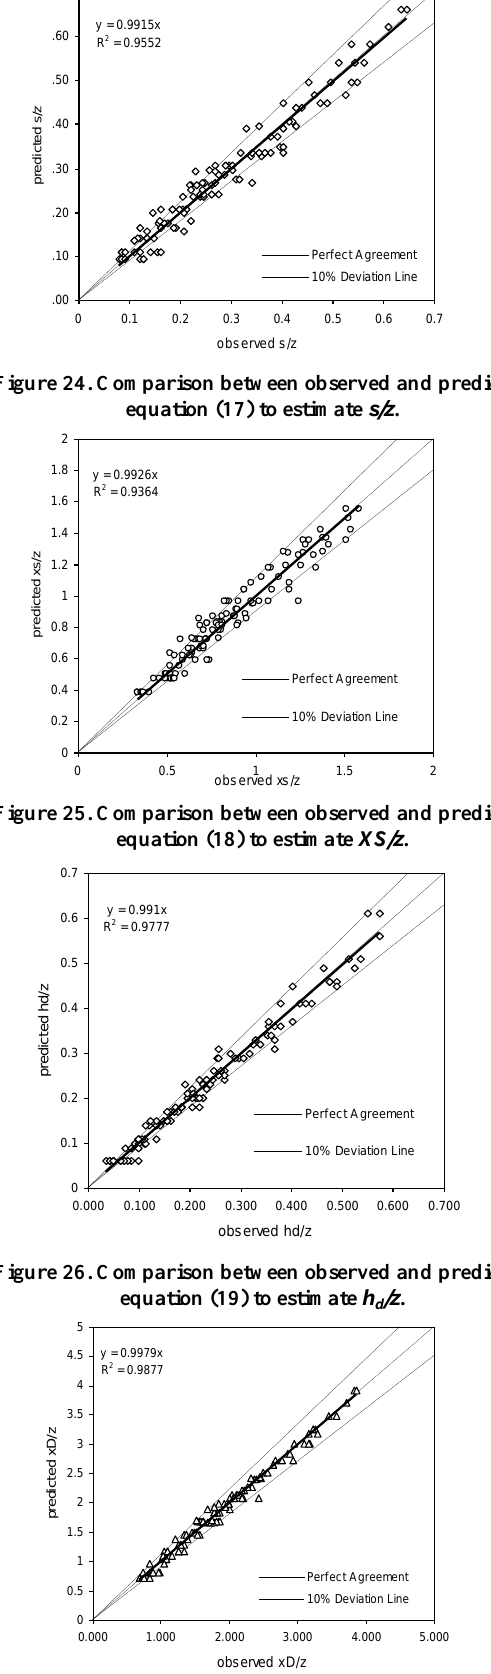
Figure 27. Comparison between observed and predicted equation (20) to estimate XD/z